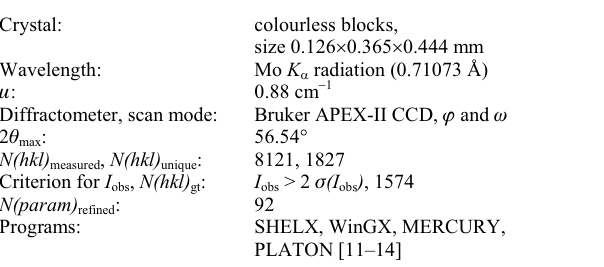
Table 1. Data collection and